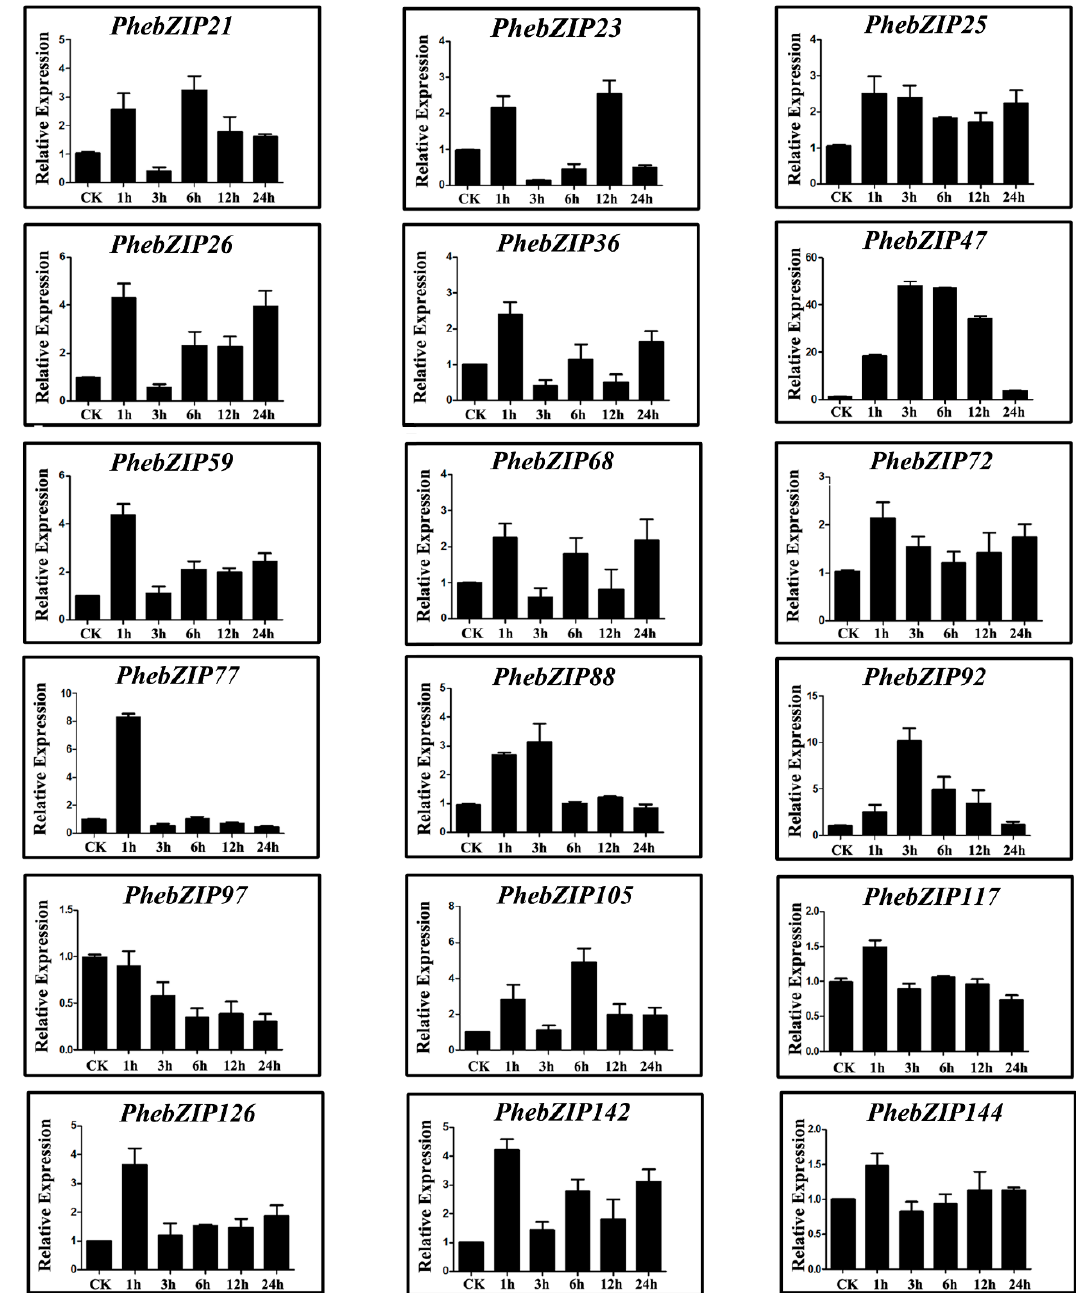
Figure 8. qRT-PCR expression analysis of selected PhebZIP genes following abscisic acid (ABA) treatment. Sampling occurred 0, 1, 3, 6, 9, 12, and 24 h after treatment and the relative expression levels were analyzed. Untreated sample expression levels = 1. X-axes represent time points after ABA treatment. Y-axes represent relative gene expression values normalized to the reference gene TIP41 . Bars indicate standard deviations (SD) from three biological replicates.